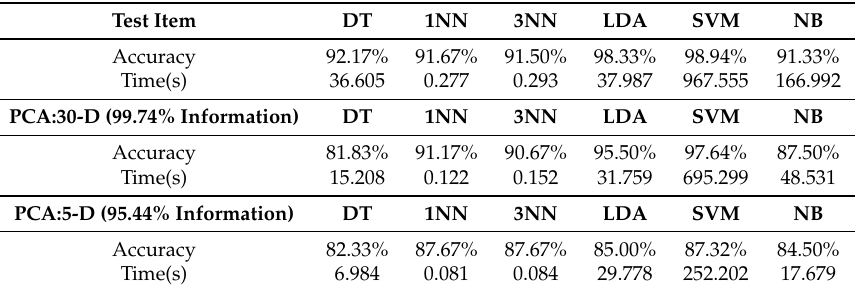
Table 5. PCA analysis in terms of accuracy and time